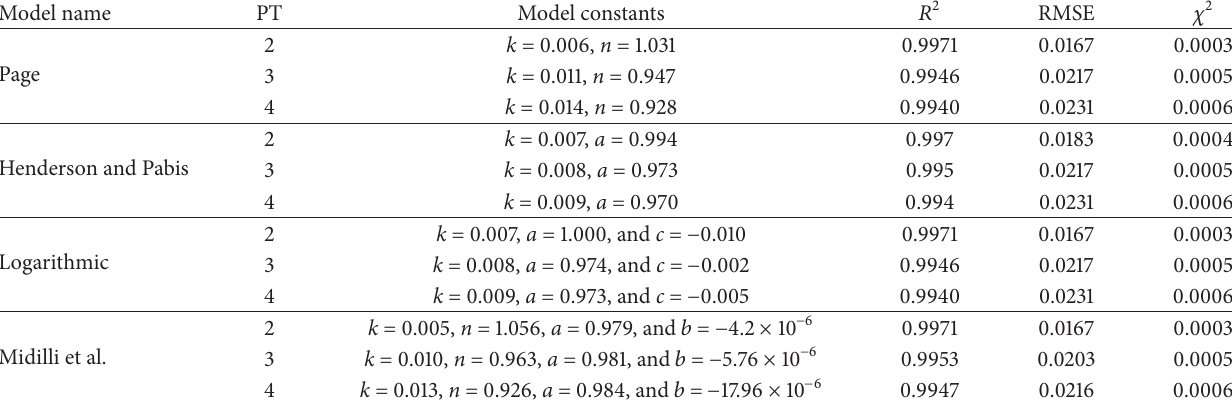
Table 4: Parameters and statistical results for the various drying models for microwave pretreated samples at 300 W.